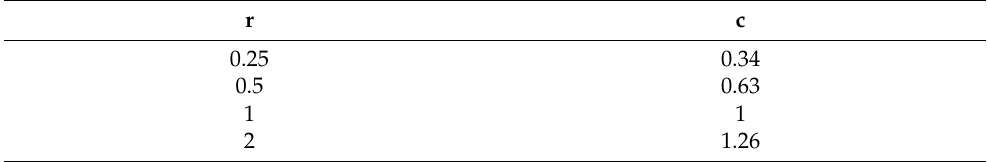
Table 6. c coefficient as a function of r [57].